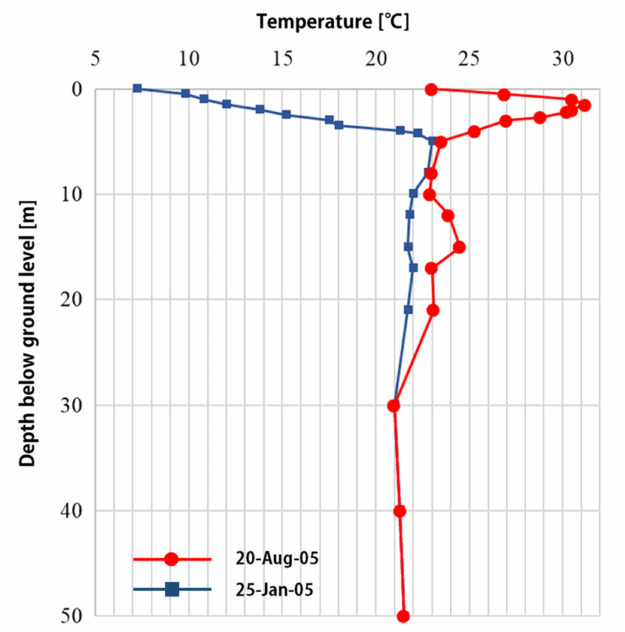
Figure 1. Ground temperature as a function of depth below surface.